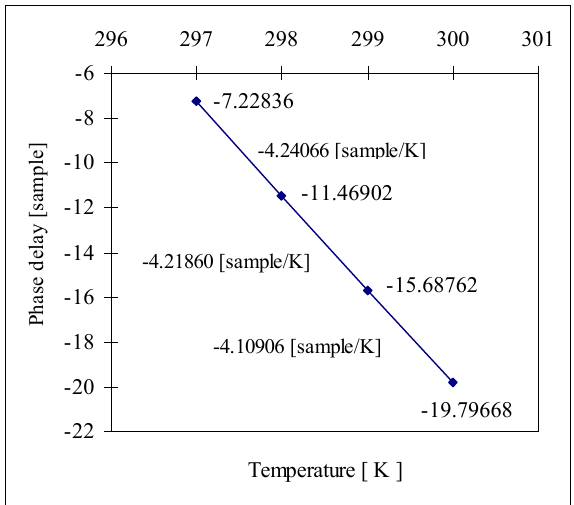
Figure 4 . Phase delay ΔΦ i decrease in absolute temperature